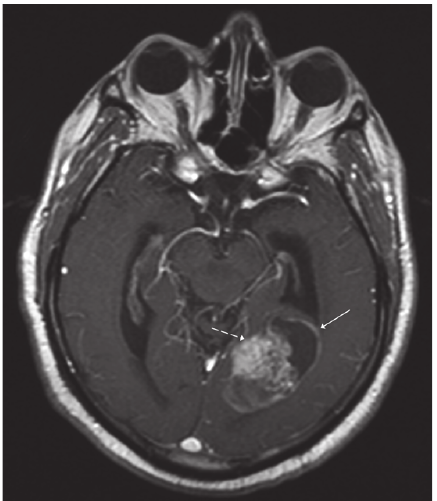
Figure 1: Noncontrast axial computed tomography image shows a mixed solid (dashed white arrow) and cystic (solid white arrow) temporooccipital mass with a hyperattenuating solid component and a punctate calcification peripherally (dotted white arrow).